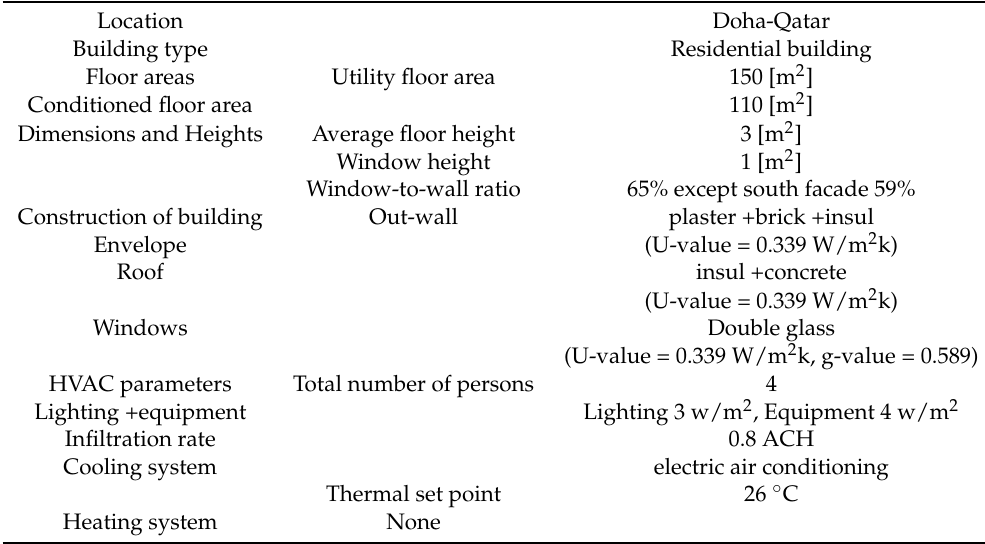
Table 6. Brief description of the base building parameters for